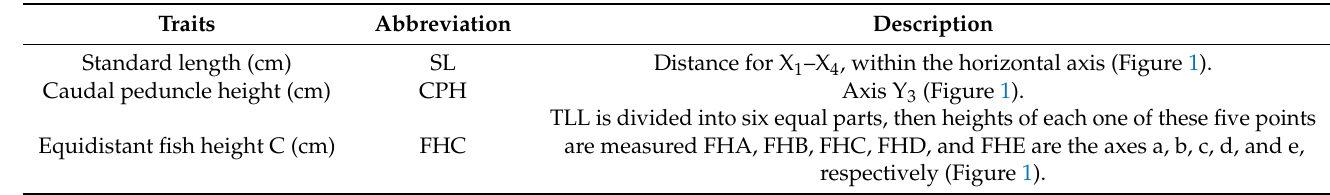
Table 2. The measured trait by IMAFISH_ML